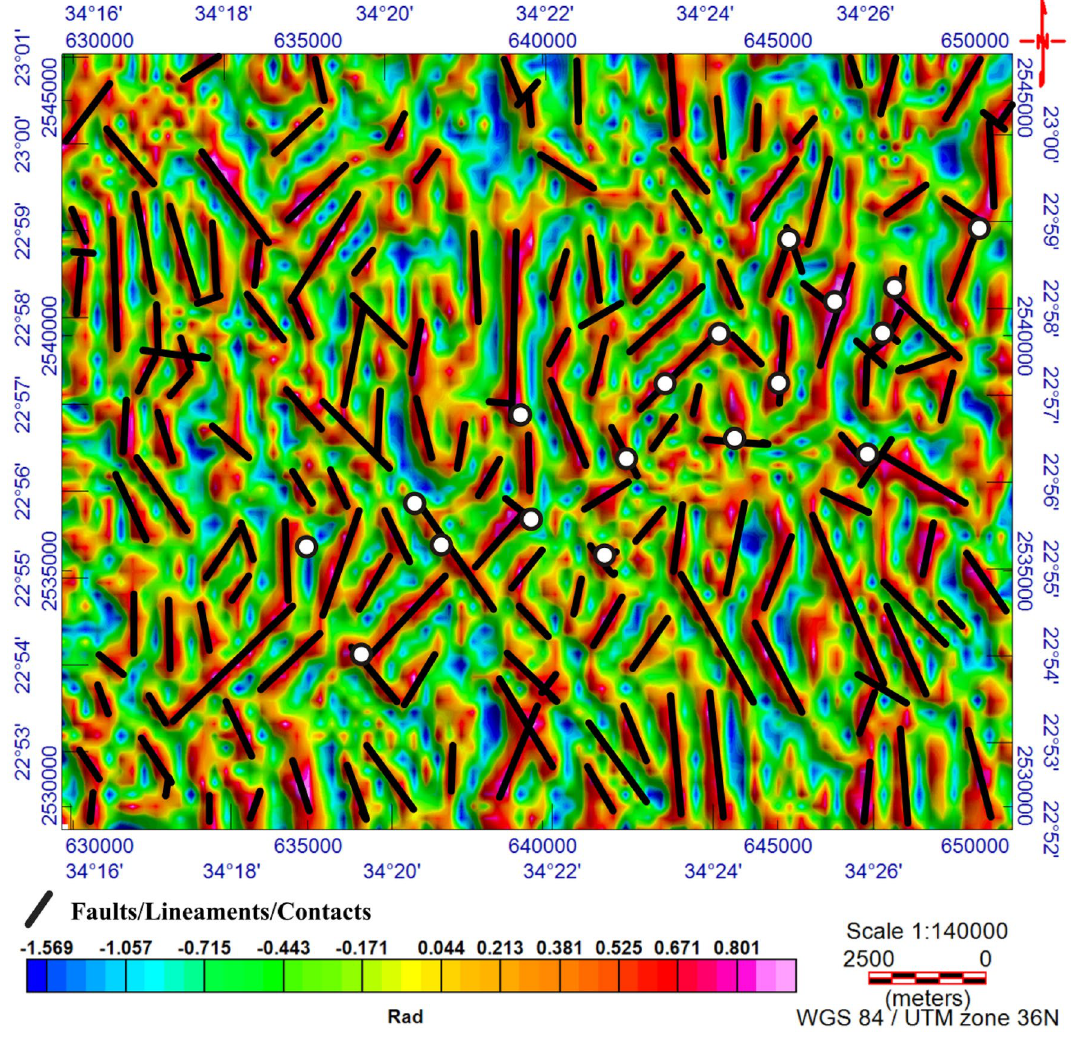
Figure 5. The EHGA map of the study area with rock